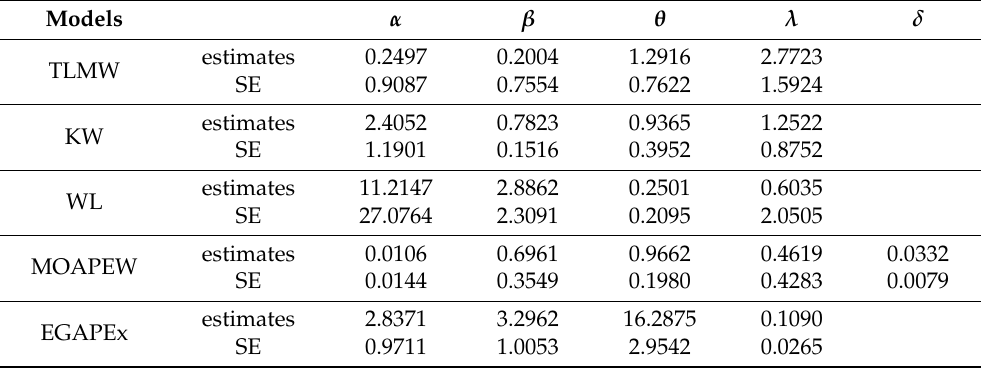
Table 10. MLE for parameters of TLMW and comparative models for Guinea Pigs data.